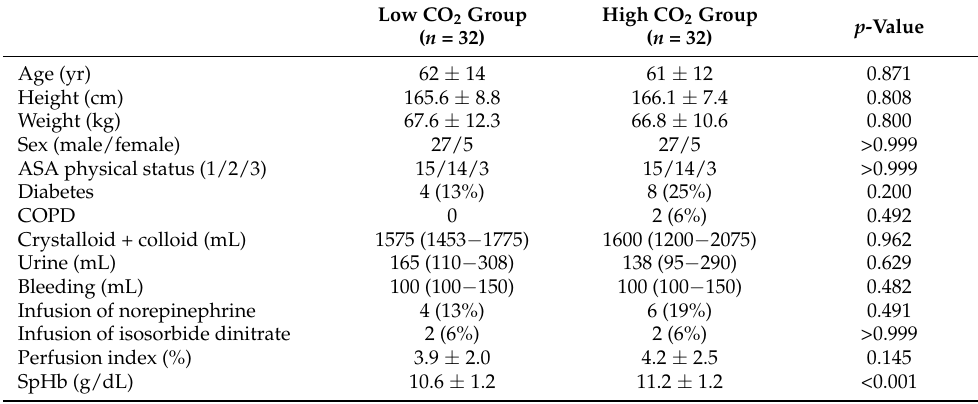
Table 1. Patient characteristics and perioperative profiles.